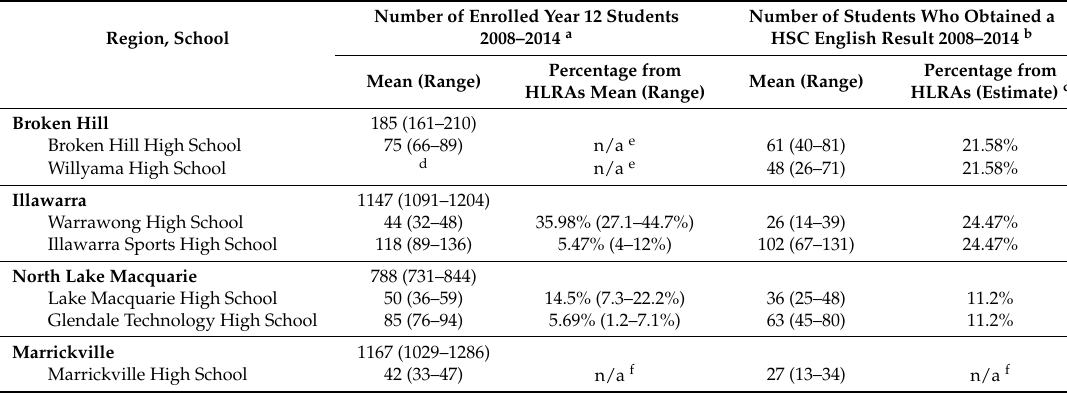
Table 2. Summary statistics of student numbers in each community, ‘Leaded’ school and in the highest lead risk areas